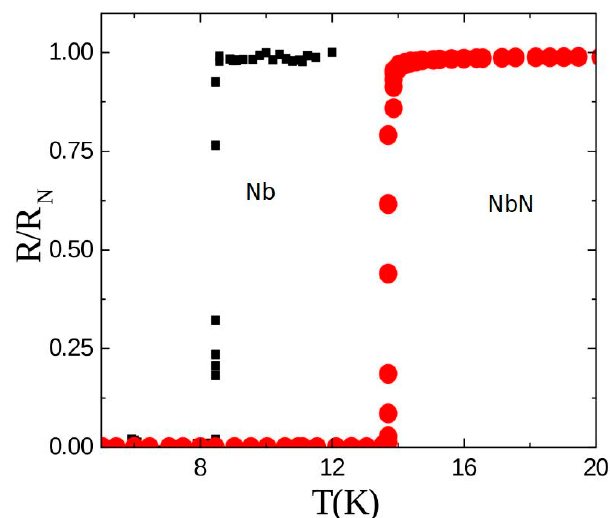
Figure 3. Normalized resistance of two Nb and NbN strips, showing the onset of the superconducting state at T c (Adapted from [12], with the permission of IOP Publishing).